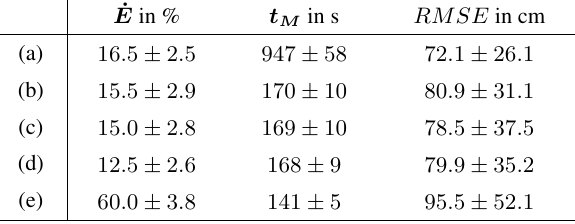
Table 3: Test results of House data set: failure rate ˙ E , matching time t M , and accuracy (RMSE) of coarse alignment.